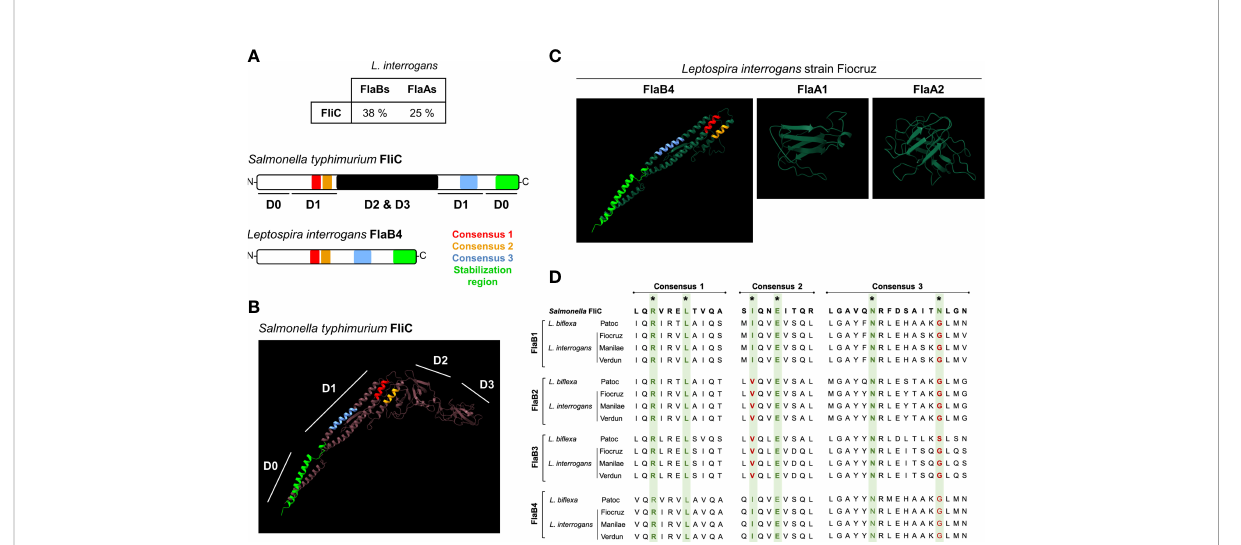
FIGURE 6 (A) Amino acid sequence homology average percentage between Salmonella typhimurium FliC (P06179) and Leptospira interrogans strain Fiocruz FlaB (LIC11890, LIC11889, LIC 11532 and LIC11531) and FlaAs (LIC10788 and LIC10787) and primary structures of the fl agellin proteins with TLR5 binding consensus. (B) In silico (Phyre2 and Chimera softwares) prediction of Salmonella typhimurium FliC (P06179) structure with the four described domains and with positions of the TLR5 binding consensus: 1 (red), 2 (yellow) and 3 (light blue) and stabilization region (light green) highlighted. (C) In silico (Phyre2 and Chimera softwares) prediction of Leptospira interrogans strain Fiocruz FlaB4 (LICI1531) with the positions of the TLRS binding consensus and stabilization region highlighted, FlaA1 (LIC10788), FlaA2 (LICI0787). (D) Clustal (MEGA software) alignment of the amino acid sequences for the TLR5 binding consensus regions of: Salmonella enterica FliC (GeneBank QDQ31983.1), L. bi fl eva (strain Patoc) FlaB1 (LEPBla2133), FlaB2 (LEPBIa2132), FlaB3 (LEPBla1872) and FlaB4 (LEPBla1589), L. interrogans (strain Fiocruz L1-130) FlaB1 (LIC18890), FlaB2 (LICIT889), FlaB3 (LICI1532) and FlaB4 (LIC11531), L. interrogans (strain L495) FlaB1 (LMANv2 260016), FlaB2 (LMANv2 260015). FlaB3 (LMANv2 590024) and FlaB4 (LMANv2 590023), and L. interrogans (strain Verdun) FlaB1 (AKWP_v1_110429), FlaB2 (AKWP_v1_110428)